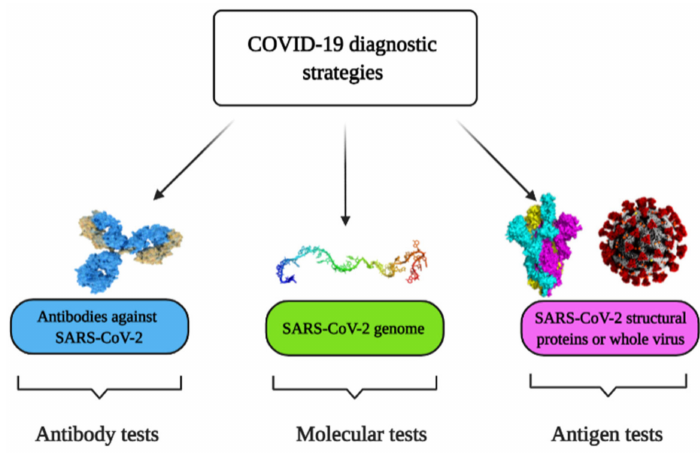
Figure 1. Coronavirus disease 2019 (COVID-19) diagnostic